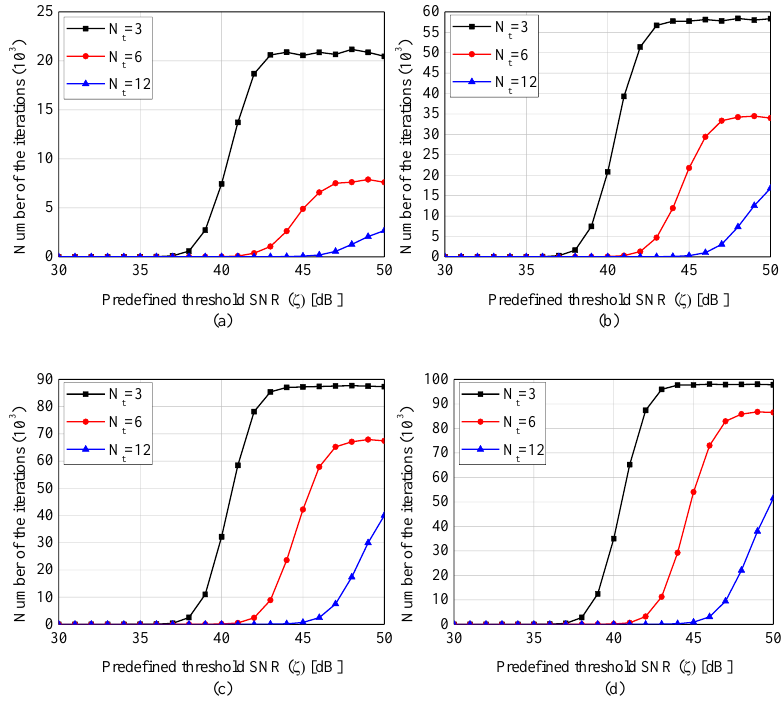
Figure 10. The simulated number of the iterations of the proposed algorithm versus ζ when ν is set as ( a ) 2 dB, ( b ) 4 dB, ( c ) 8 dB, and ( d ) 16 dB, respectively.